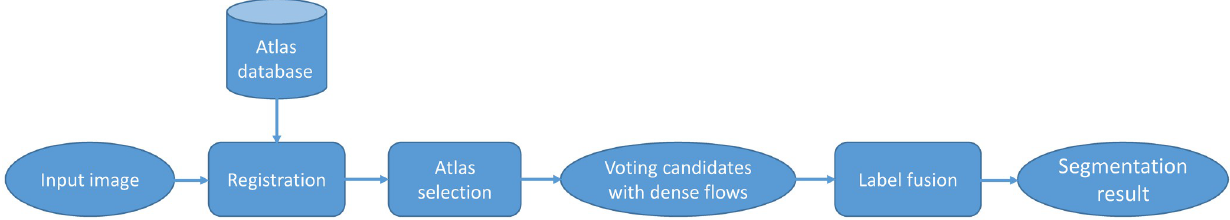
Fig 1. A simple diagram for the pipeline of our proposed system. The rectangles are three key components in our system: registration, atlas selection, and label fusion. Ovals and cylinders denote data representations.